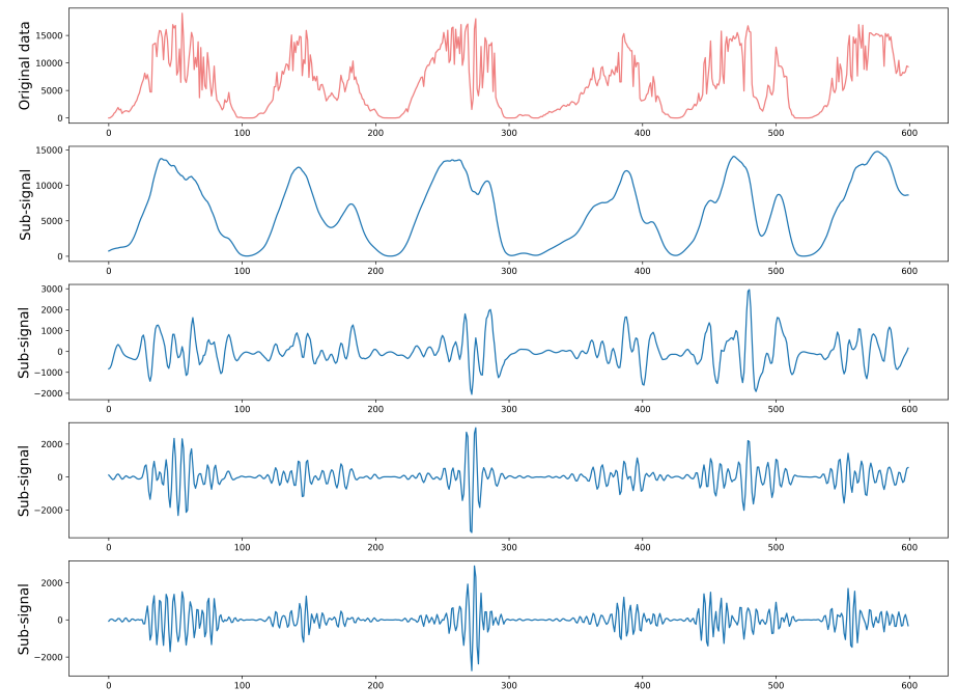
Figure 1. SSA decomposed several subsequences of the original time series.